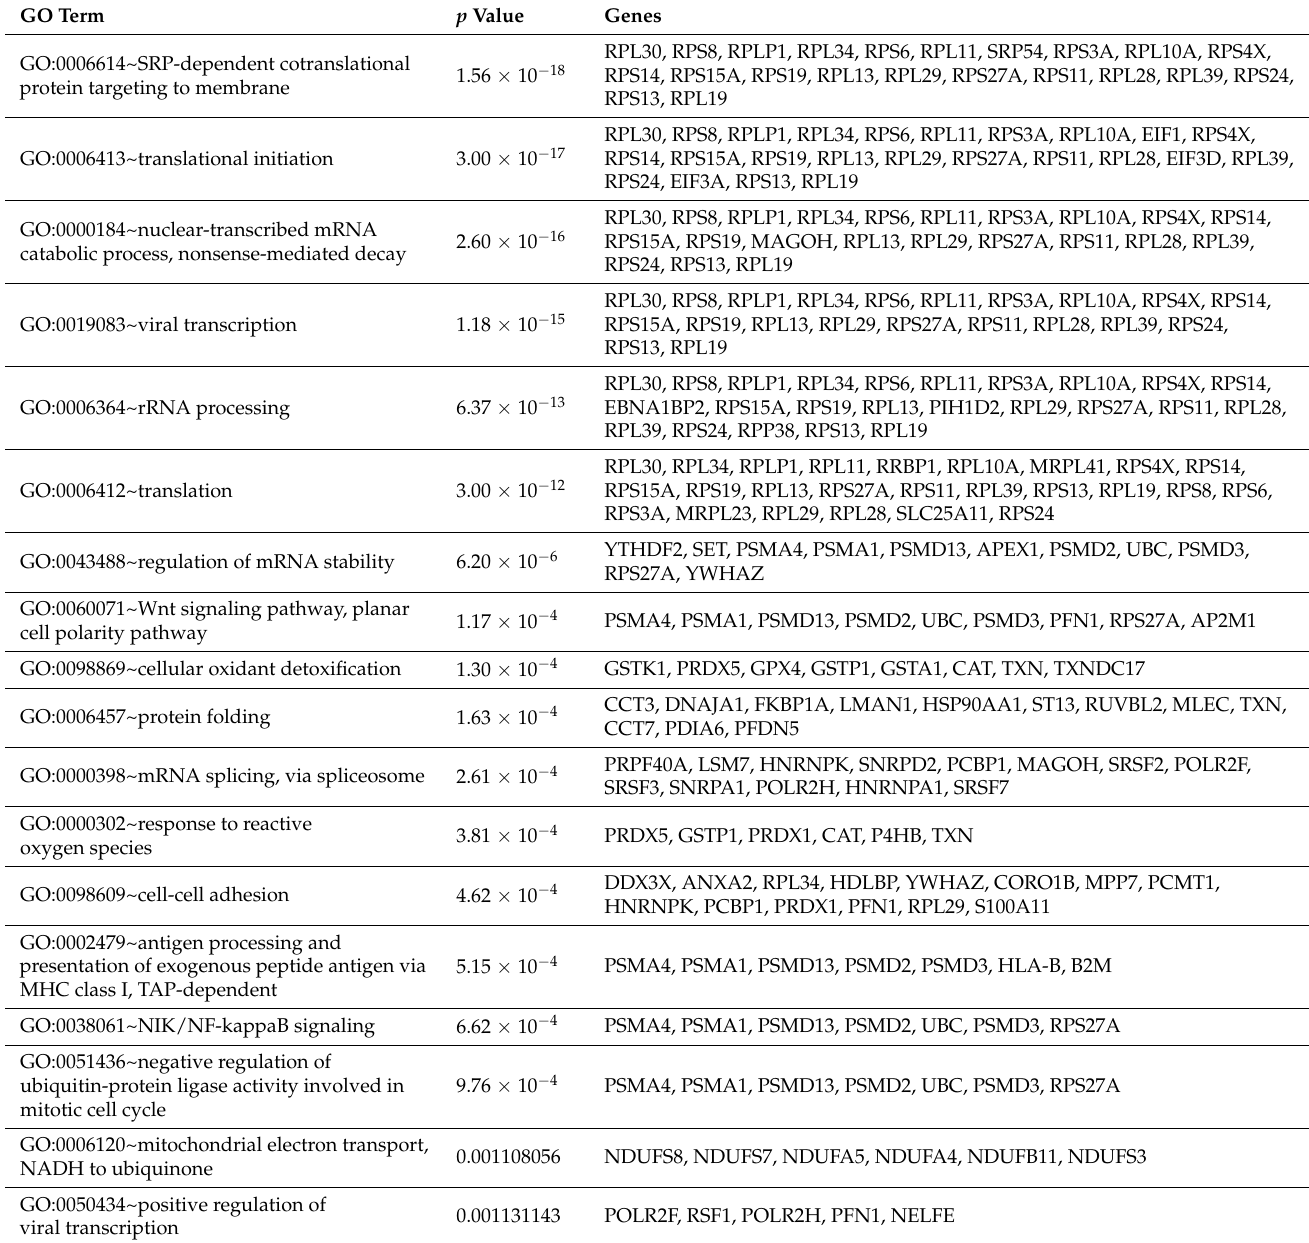
Table 1. Pathways upregulated in healthy ciliated